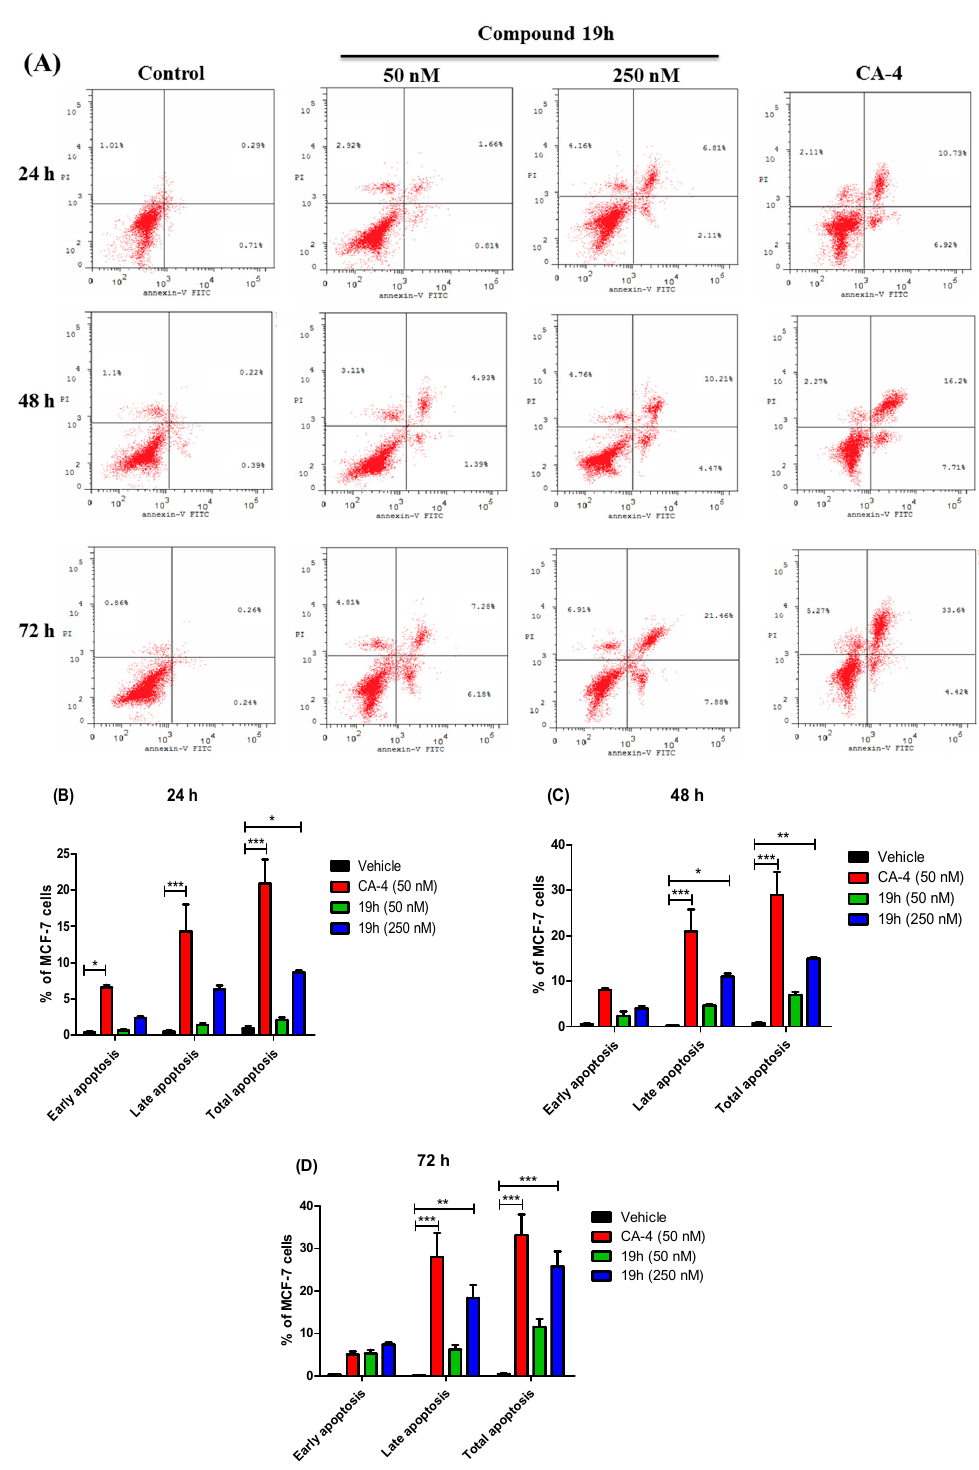
Figure 5. ( A ) Flow cytometric analysis of apoptotic cells after treatment of MCF-7 cells with 19h at different time points after double staining of the cells with Annexin-V-FITC and PI. MCF-7 cells treated with 50 and 250 nM of compound 19h and 50 nM of CA-4 for 24 h, 48 h and 72 h. Quantitative analysis of apoptosis for ( B ) 24 h, ( C ) 48 h, ( D ) 72 h. All values represent the mean ± SEM for three independent experiments. Statistical analysis was performed using two-way ANOVA (*, p < 0.05; **, p < 0.01; ***, p <